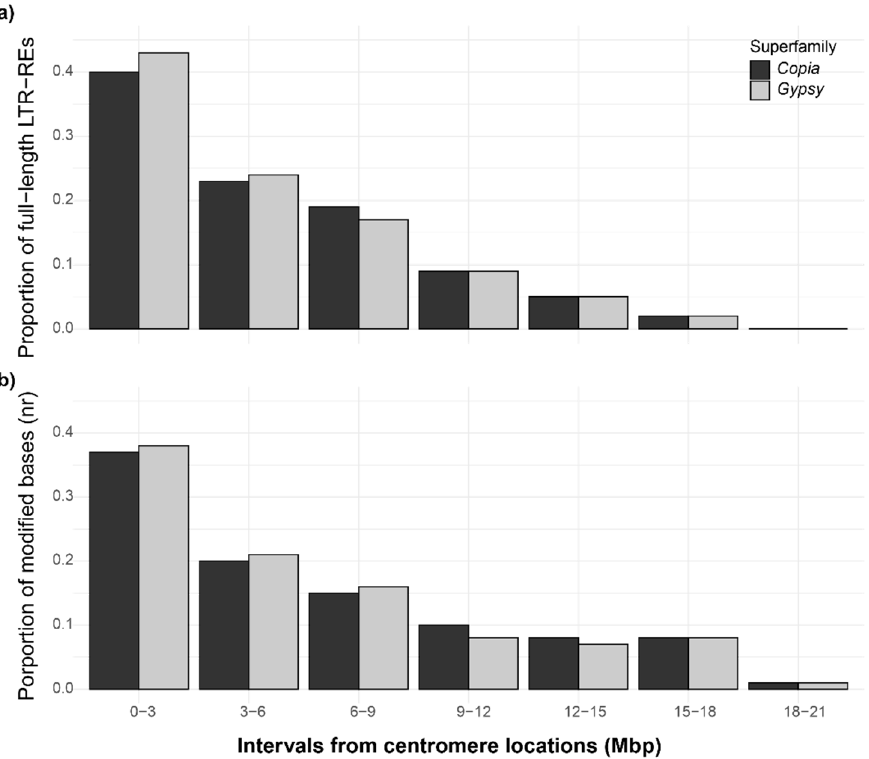
Figure 4. Bar plots of the full-length LTR-RE ( a ) and modified bases (4mC and 6mA, b) distributions according to their proximity to the centromere of the 13 F. carica pseudo-chromosomes in the Copia and Gypsy superfamilies. Starting from the center of the centromeric regions (point 0–3 on the x axis), 3 Mbp bins upstream, downstream, and reverse were considered. The distributions of each superfamily were normalized based on the total number of elements ( a ) or the total number of modified bases ( b ).